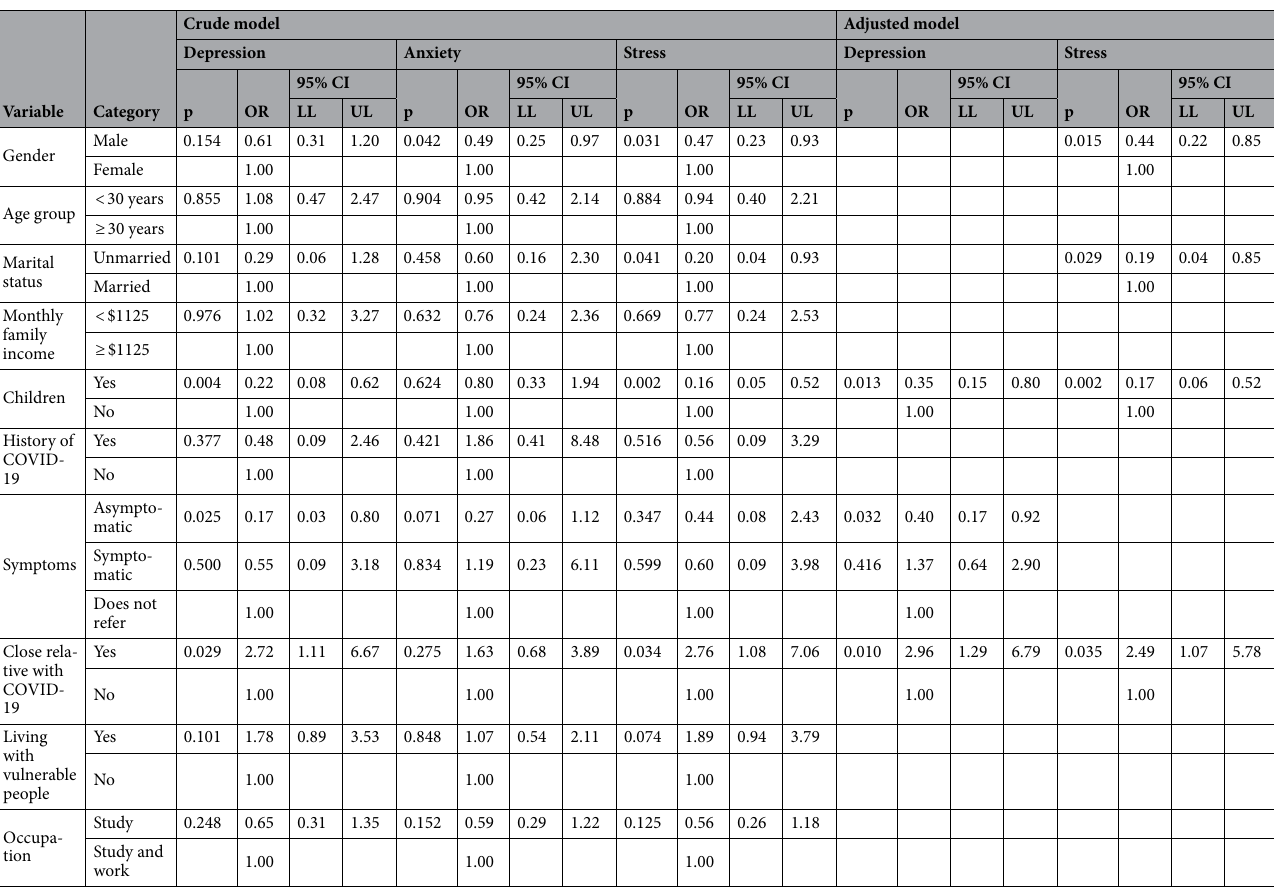
Table 5. Multivariate logistic regression model of Depression, Anxiety and Stress in dental students according to their associated factors. *p < 0.05significant association according to regression model (a: was not significant in the adjusted model). a: Gender was not included in the adjusted model for anxiety as a p > 0.05 was obtained. The model effect size (Nagelkerke’s R2) for depression was 0.210 and for stress was